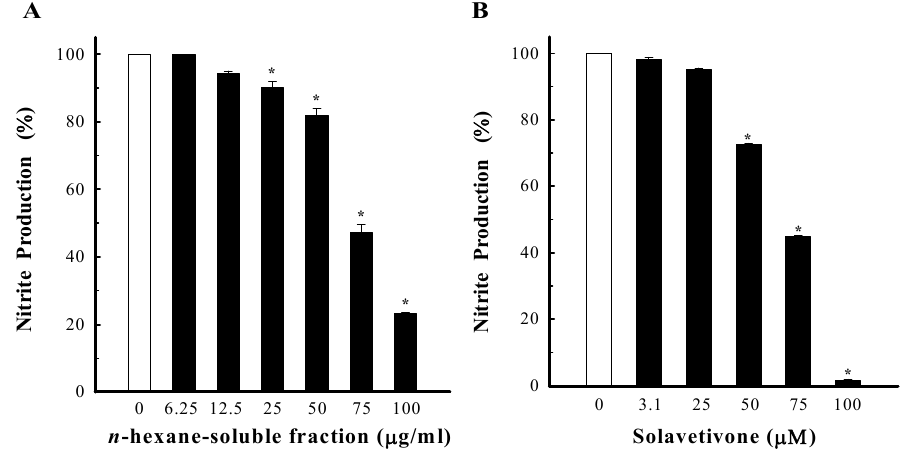
Figure 4. The effect of n -hexane-soluble fraction ( A ) and solavetivone ( 3 ) ( B ) on nitrite production in LPS-activated RAW 264.7 cells. Vehicle representative of 100% is equal to 35.28 ± 0.57 μ M of NO produced in the medium per well of cells. n = 5–6 in each group. * p < 0.05 when compared with vehicle-treated cells.